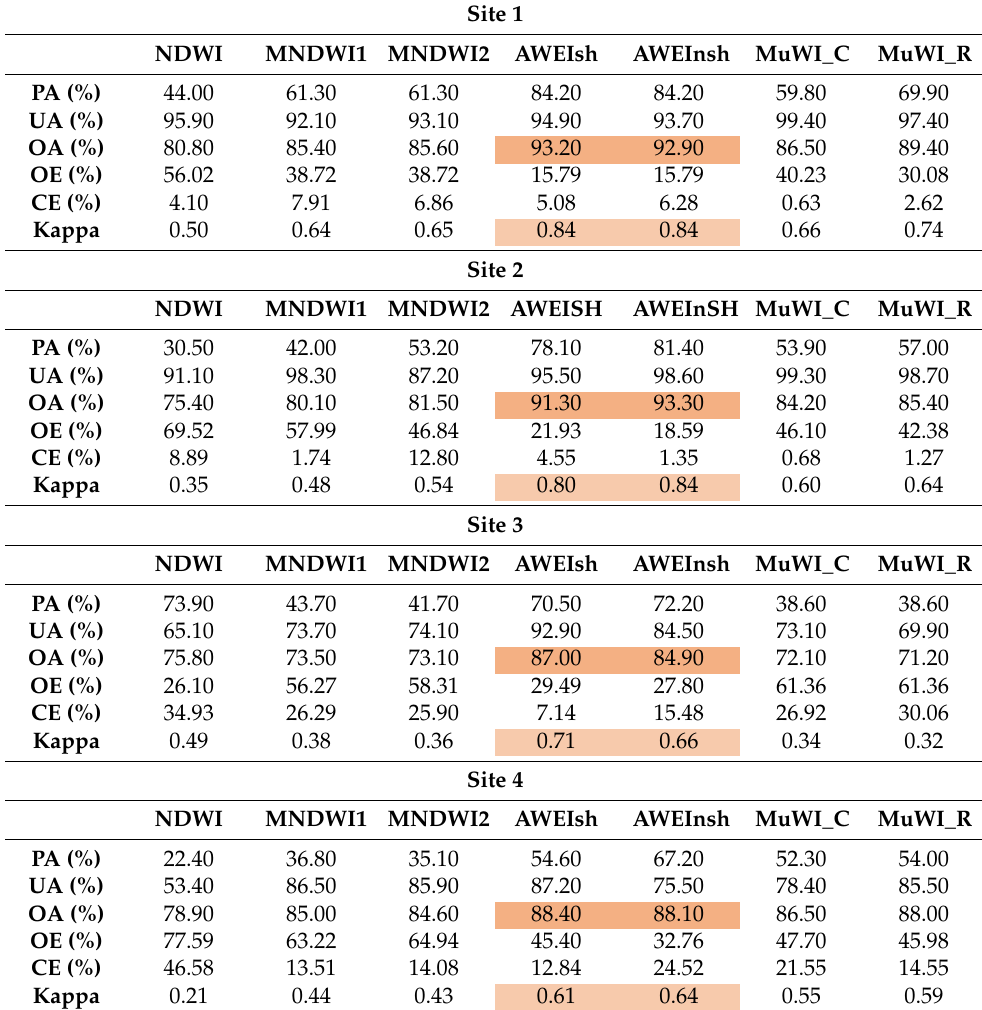
Table 3. Accuracy assessment of water maps for sites 1, 2, 3, and 4 of the different water indices based on the reference datasets. The OA and kappa of the best-performing indices for each site are